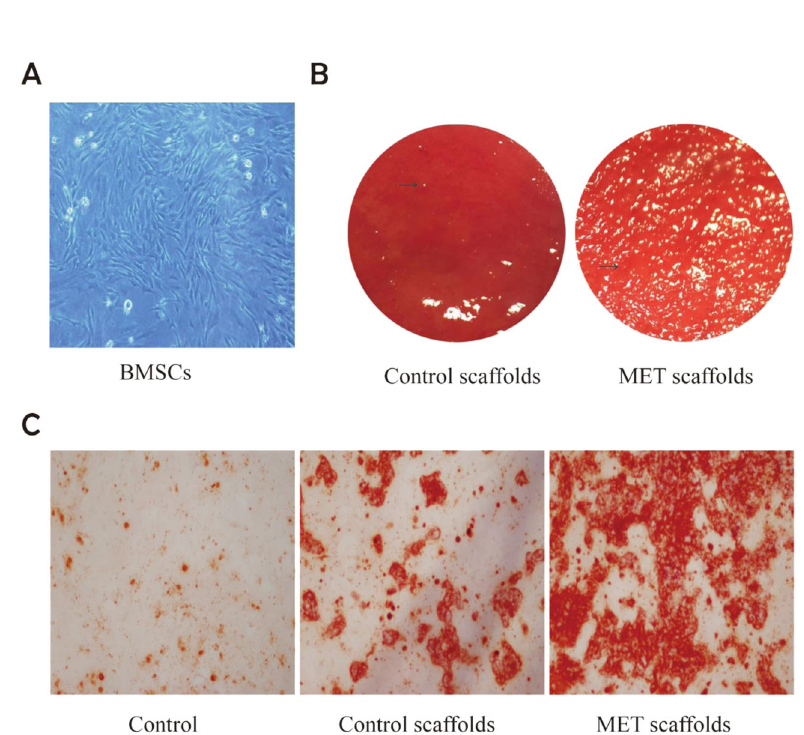
Fig. 2 A SEM images of the MET/ β -TCP/CTS/SBA- 15 scaffolds seeded with BMSCs. The arrow indicated the pseudopodia. B The porosity of the MET/ β -TCP/CTS/SBA- 15 scaffolds and the β -TCP/ CTS/SBA-15 scaffolds, respectively. C FTIR of MET/ β -TCP/CTS/SBA-15 scaffolds and β -TCP/CTS/SBA- 15 scaffolds. D XRD of MET/ β -TCP/CTS/SBA-15 scaffolds and β -TCP/CTS/SBA- 15